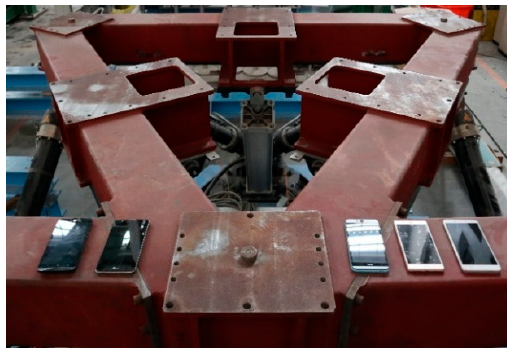
Figure 7. The smartphones mounted on the shake table.